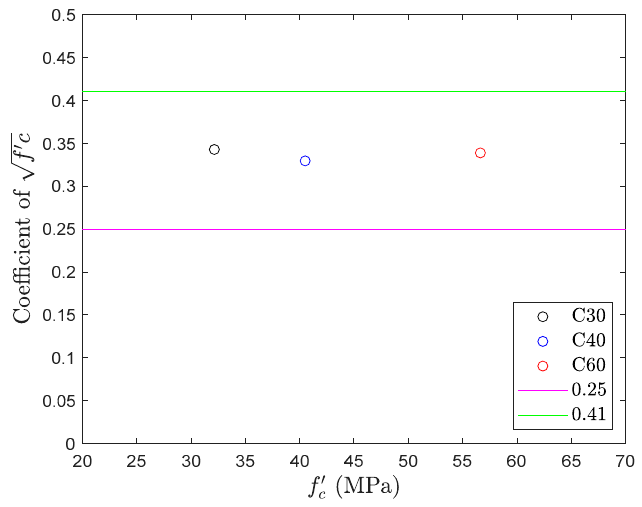
Figure 13. (cid:1858) (cid:3030) ′ coefficient of direct tension test. Figure 13. f (cid:48) c coe ffi cient of direct tension test.